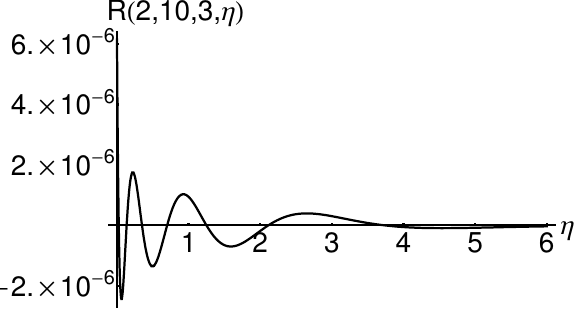
Figure 22: The residual R (2, 10, 3, η ) for Eq. (58) obtained by